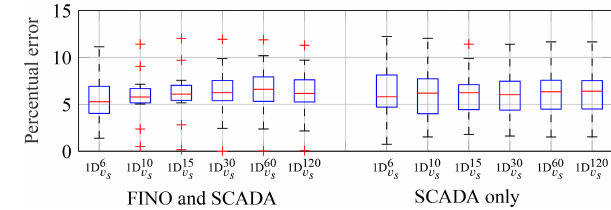
Figure A1. Percentage errors of predicted damage values using a binning method compared to real damage values. Comparison of predictions using met mast plus SCADA data and SCADA data only. Results only for 1D bins, i.e. wind speed ( v s ) bins, but var- ious bin sizes ( n ). Notations as before: 1D n x